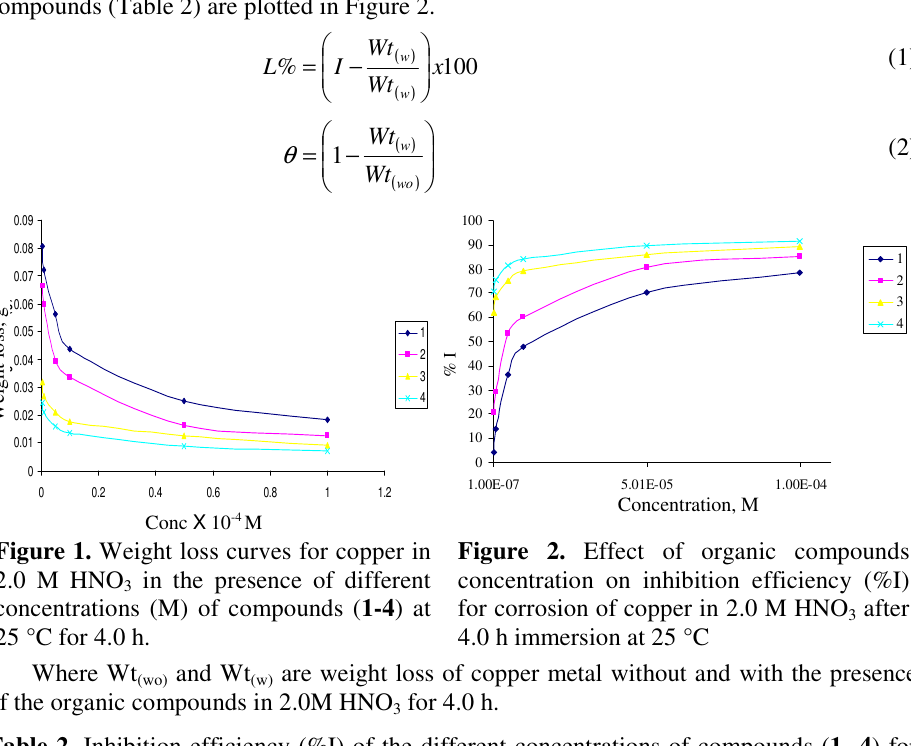
Table 2. Inhibition efficiency (%I) of the different concentrations of compounds ( 1- 4 ) for the corrosion of copper in 2.0 M HNO after 4.0 h immersion at 25 3